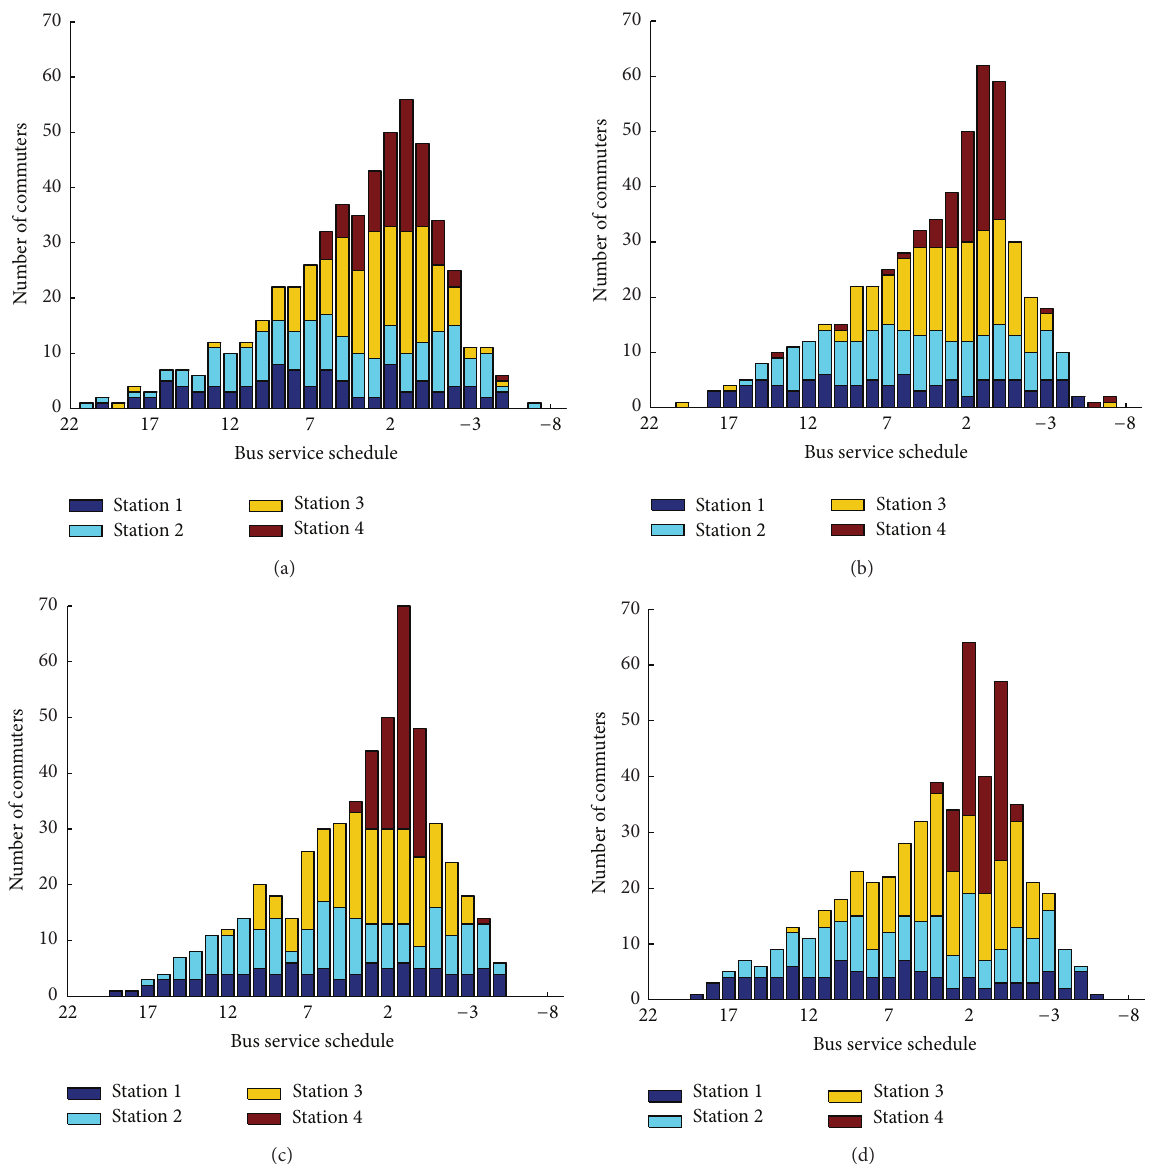
Figure 15: Snapshots of commuters’ distribution in the middle-term memory experiment. ((a) Day 500, (b) day 1000, (c) day 2000, and (d) day 3000.)